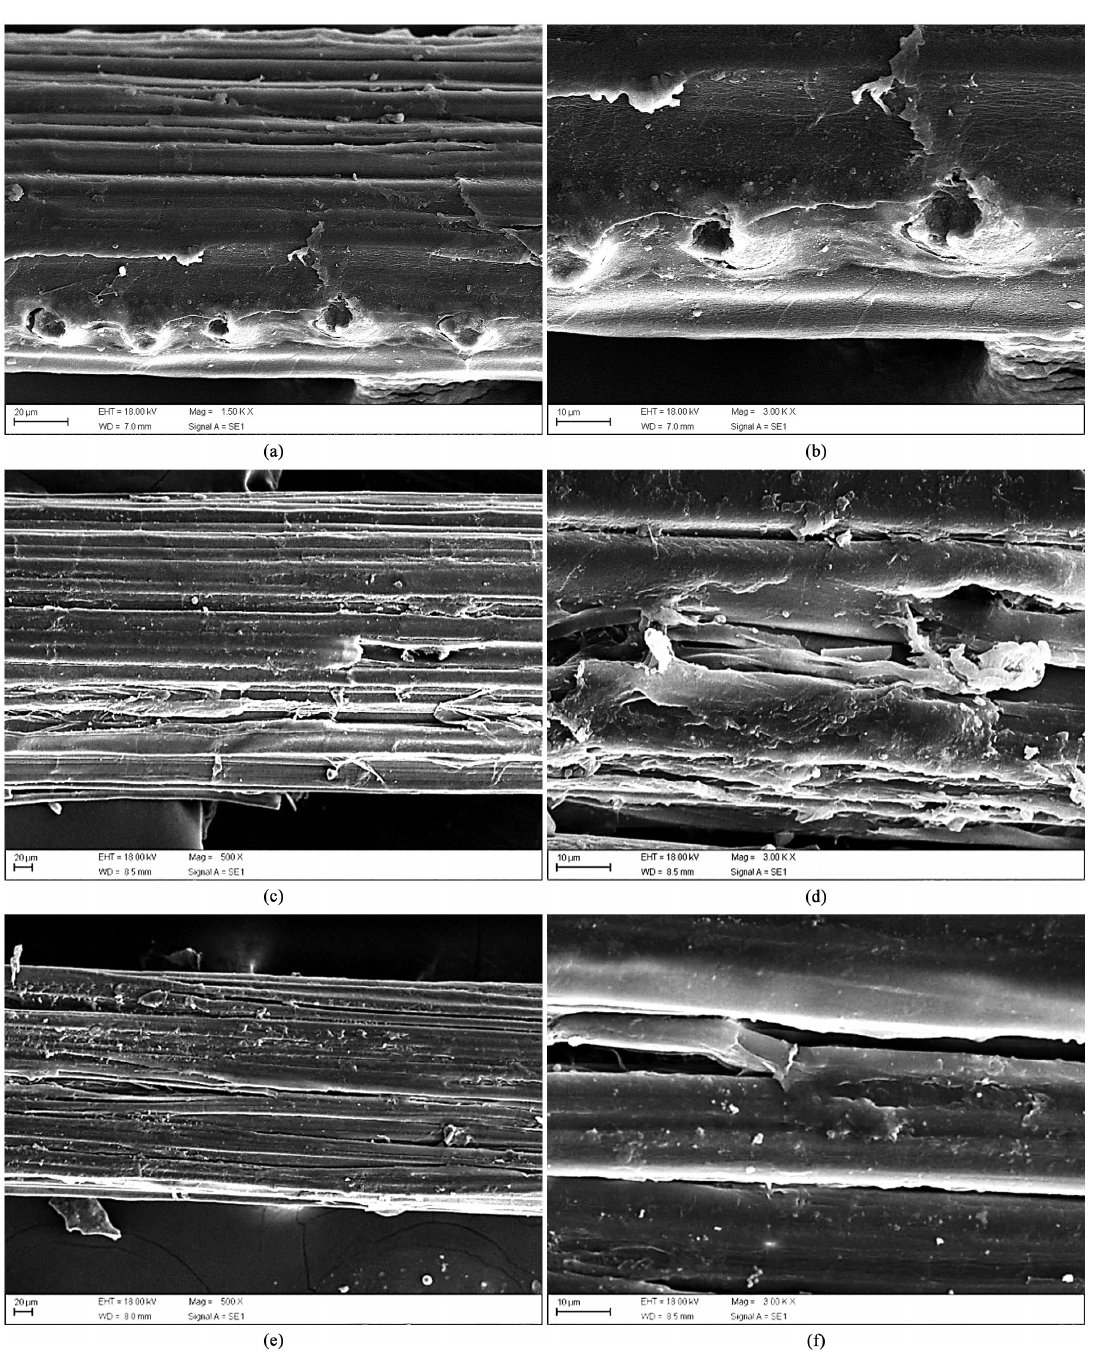
Figure 10. SEM images of BFs. (a) In Natura , (b) In Natura surface detail, (c) UV7, (d) UV7 surface detail, (e) UV15, (f) UV15 surface detail. Bibliographic source: